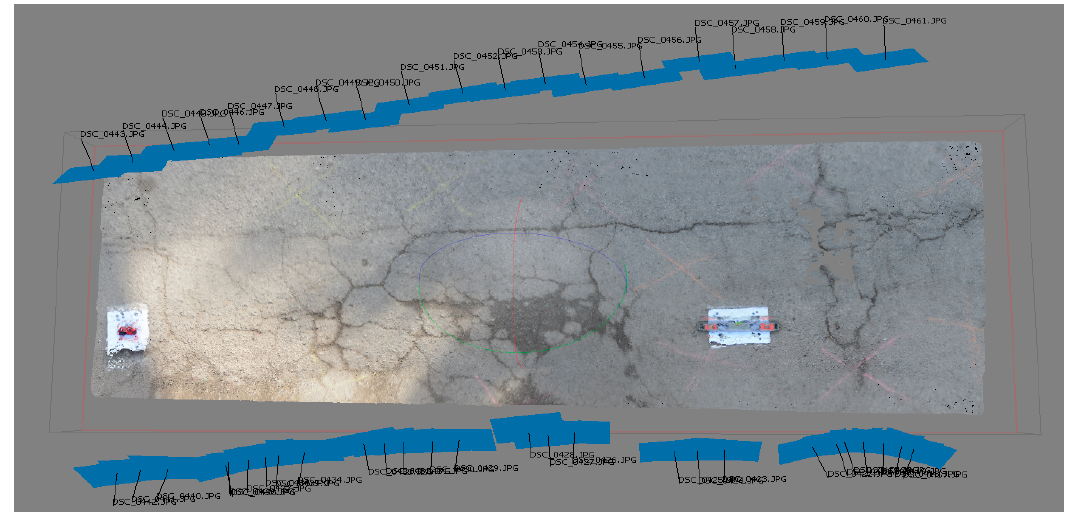
Figure 1. Example of dataset during a SfM survey of a distressed pavement section.